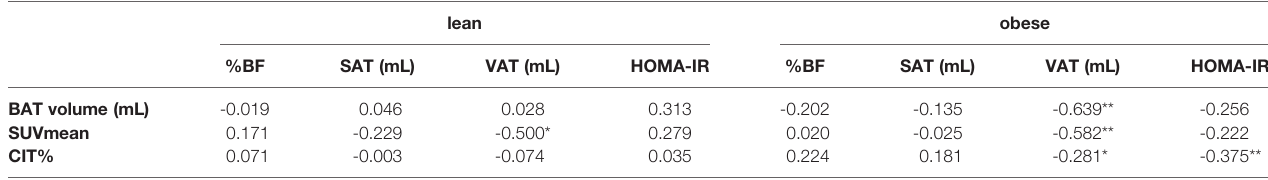
TABLE 2 | Correlation analyses between PET-derived metrics of BAT activity and body composition markers in lean and obese individuals. lean